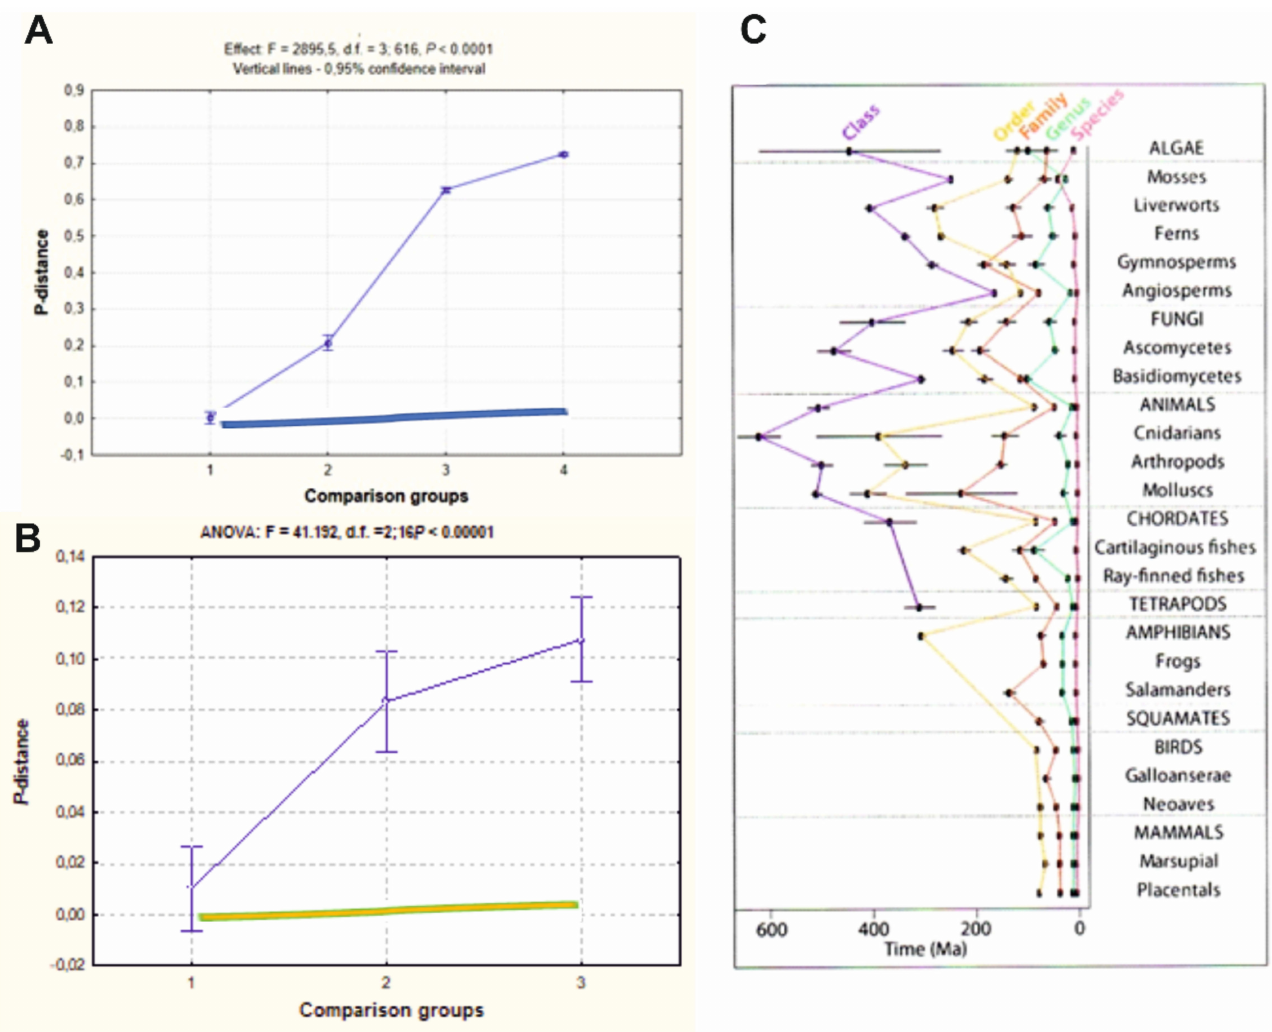
Figure 5. P -distance distribution in animal taxa for complete mitogenome in flatfish ( A ), 13 protein gene sequence data of mtDNA in minnow ( B ), and time-dependent variation for nDNA markers in a sample of 50,455 species/specimens of different taxa of Eukaryotes ( C